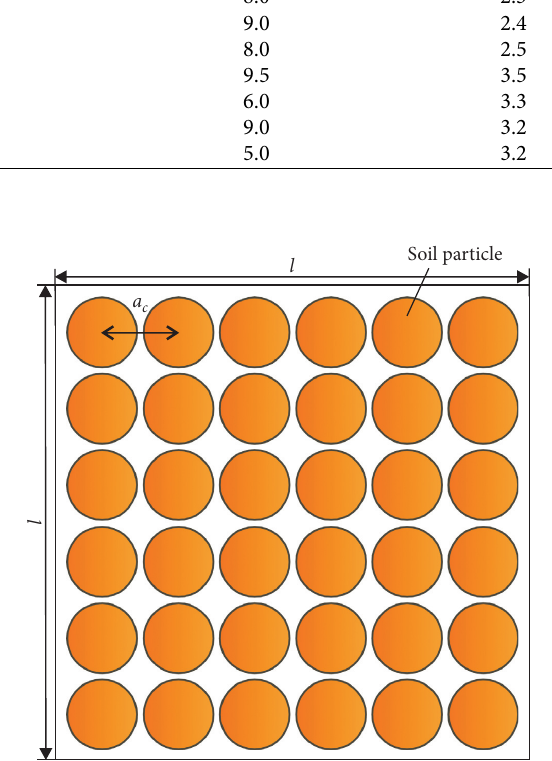
Figure 6: The cross section of soil particles